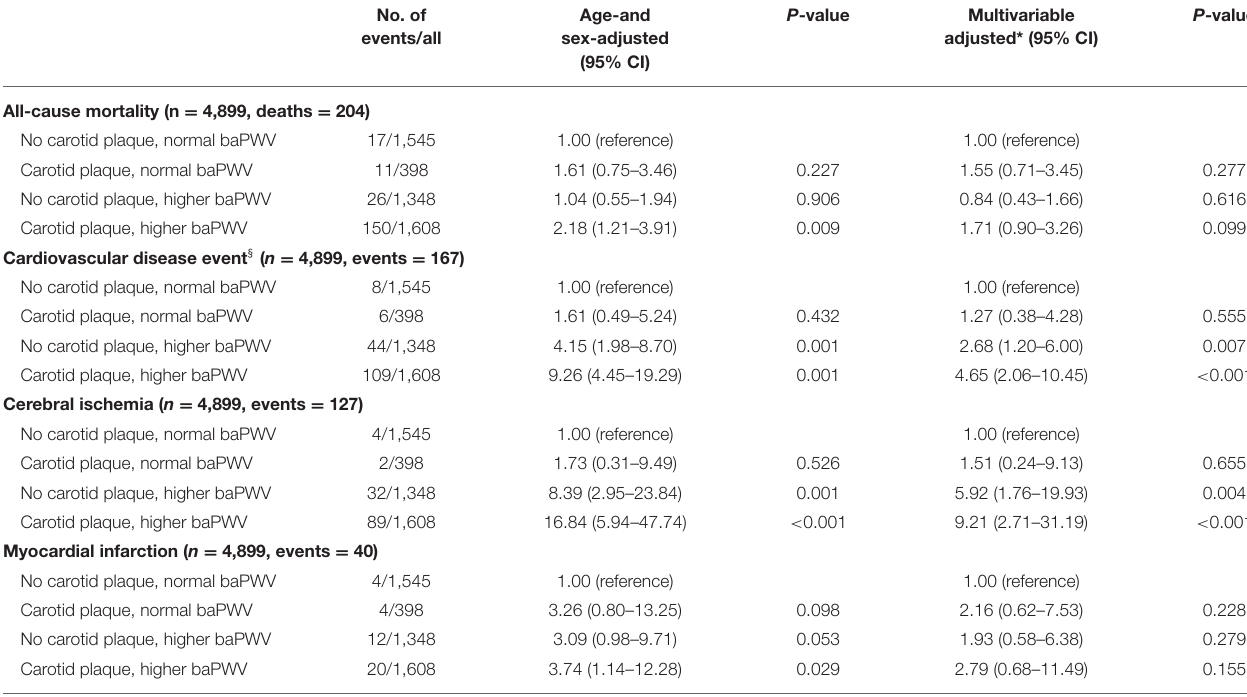
TABLE 2 | Association of carotid plaque and brachial-ankle pulse wave velocity status with all-cause mortality and cardiovascular disease events. No. of